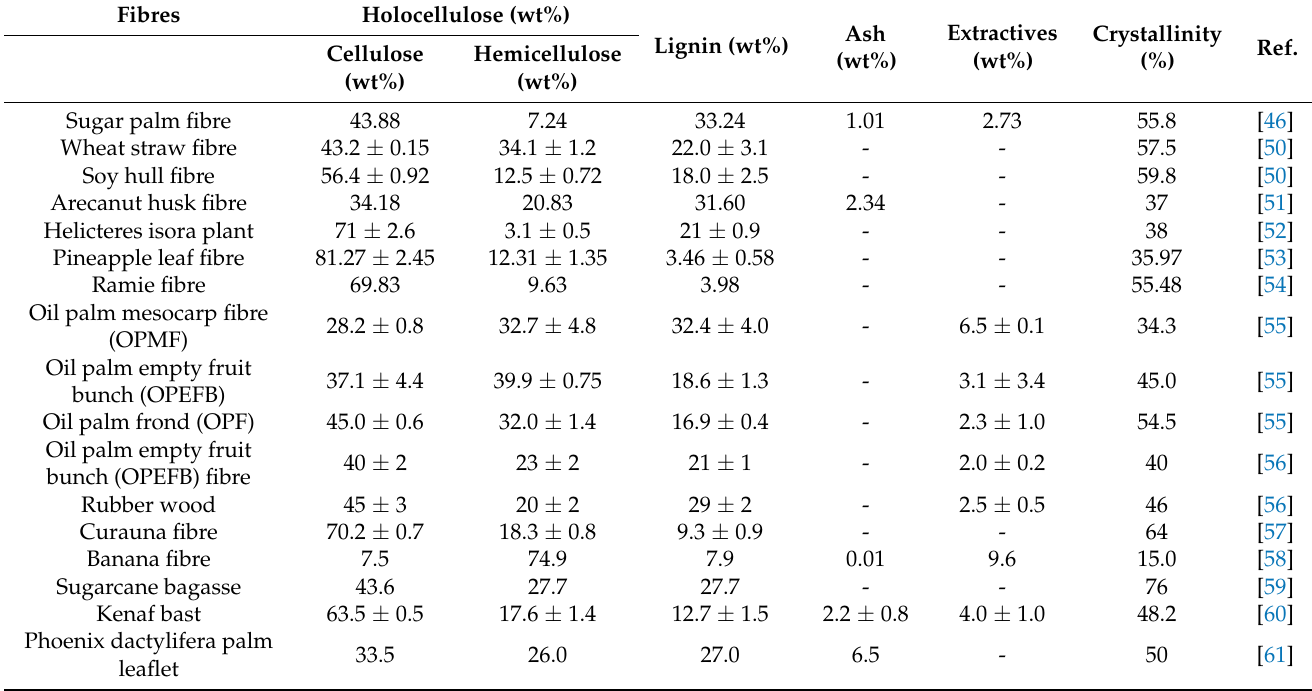
Table 1. Chemical composition of selected common natural